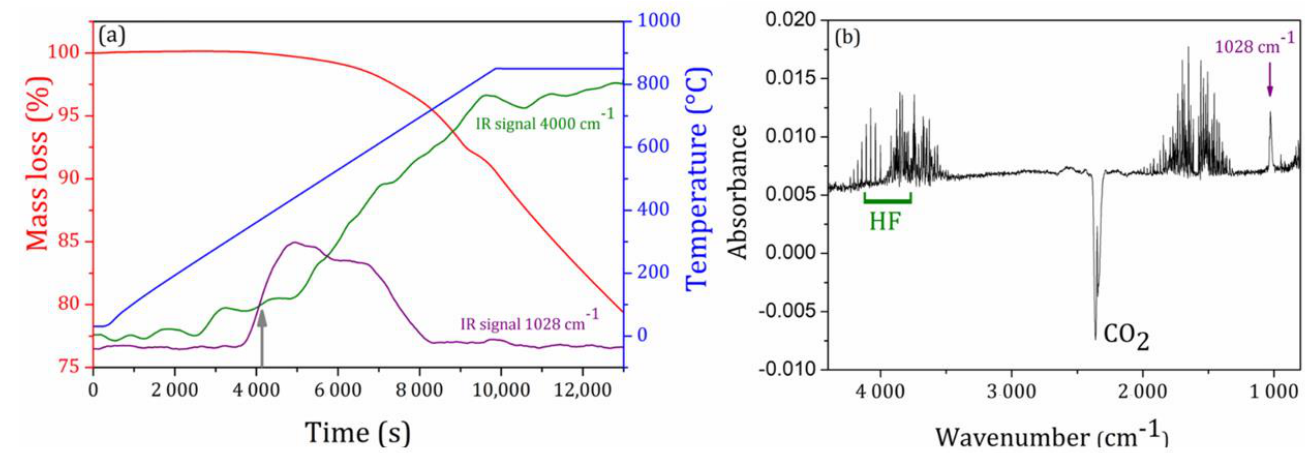
Figure 3. ( a ) Thermogravimetry of a starting powder mixture of composition 65TeO 2 -10Nb 2 O 5 -25PbF 2 , correlated absorp- tion intensities of FTIR signals centered at 1028 cm − 1 and 4000 cm − 1 and ( b ) corresponding FTIR spectrum after 4130 s of measurement (grey arrow).